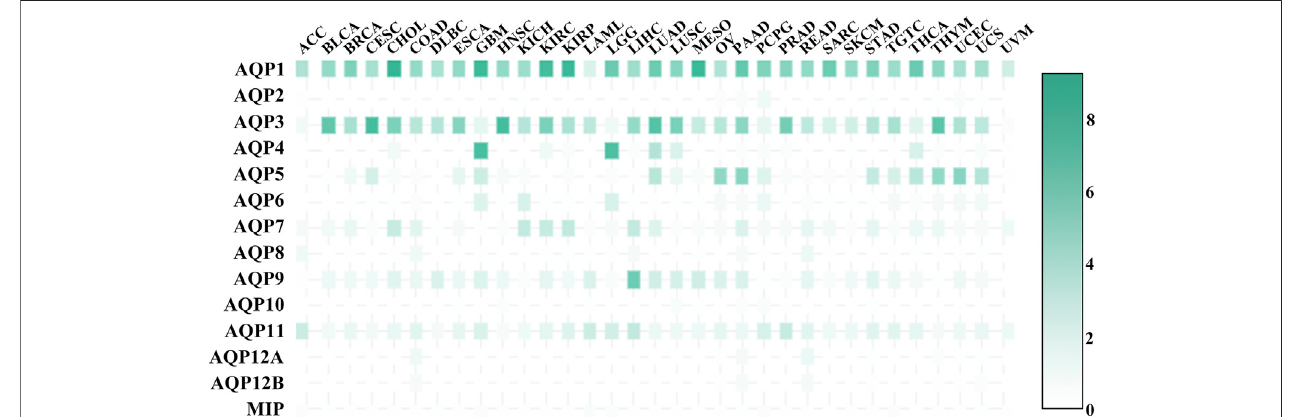
FIGURE 6 | Expression of AQPs in 33 human